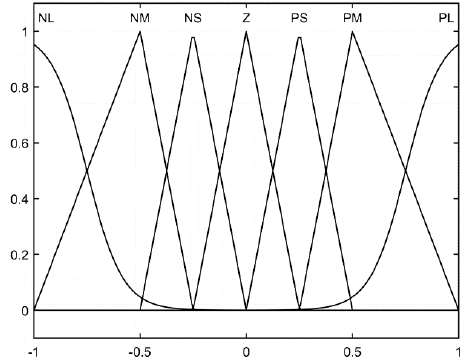
Figure 3. Input membership function.